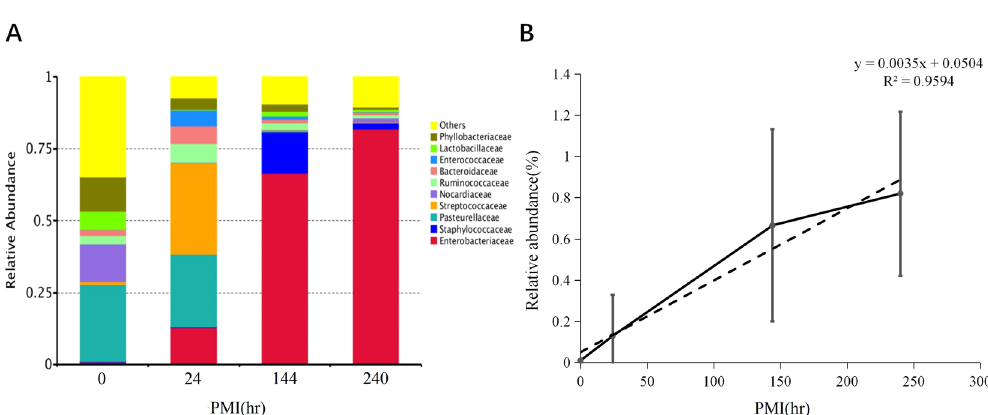
Figure 5. ( A ) Relative abundance of families of bacteria with different PMI. ( B ) Relative abundance changes of Enterobacteriaceae had high positive linear relationship with